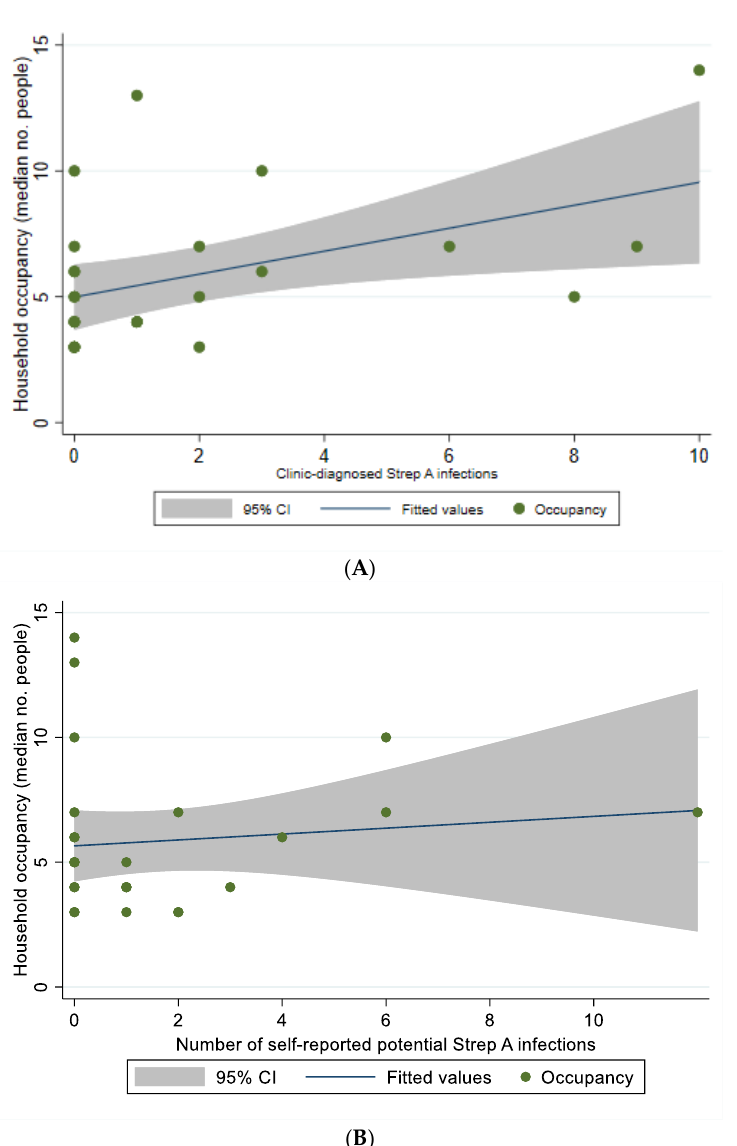
Figure 4. Association between potential Streptococcal infections and median household occupancy. ( A ) Clinic-reported potential Streptococcal Infections (skin sores and sore throats), Correlation coefficient r = 0.46 ( p = 0.018); ( B ) Self-reported skin sores and sore throats, Correlation coefficient r = 0.10, p = 0.595.